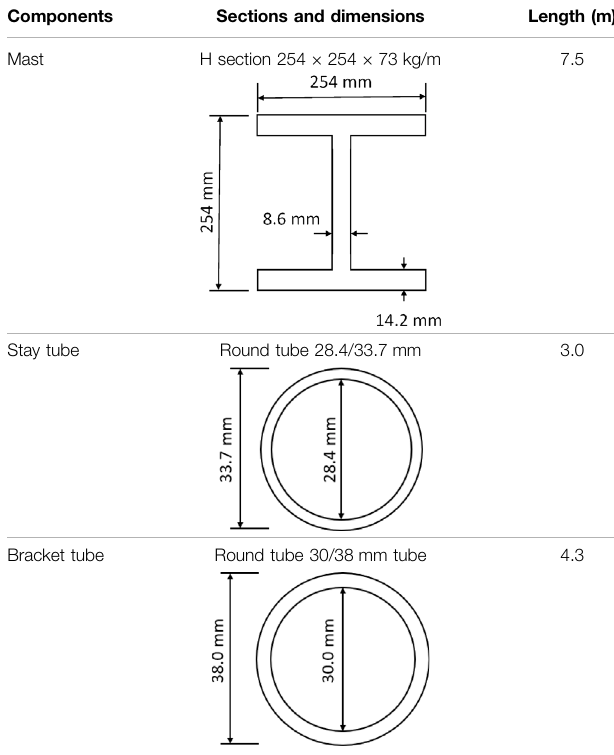
TABLE 2 | Recommended values for imperfection for buckling curves (The European Union, 2005). Buckling curve